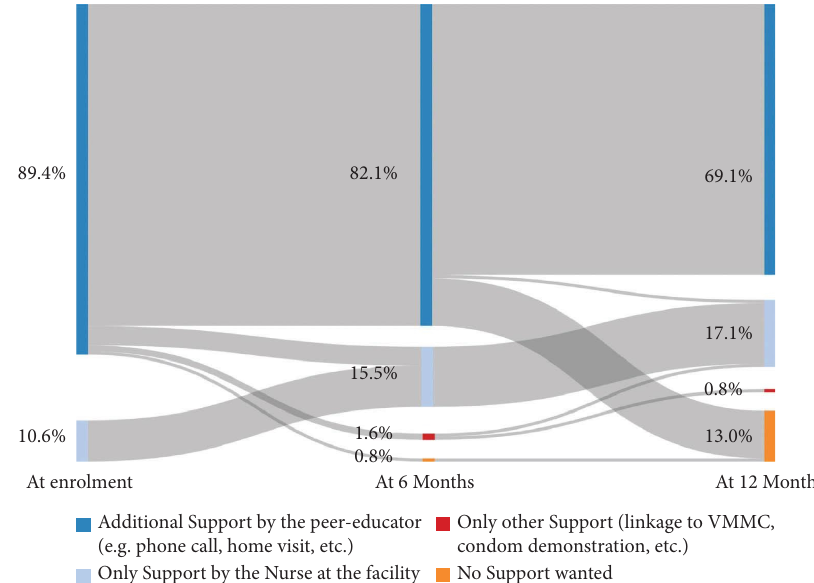
Figure 3: Sankey diagram for longitudinal visualization of support preferences. Abbreviations: VMMC (voluntary male medical circumcision). Table 1: ART refll site preferences over time, by sex, among those still in care at 12months. First